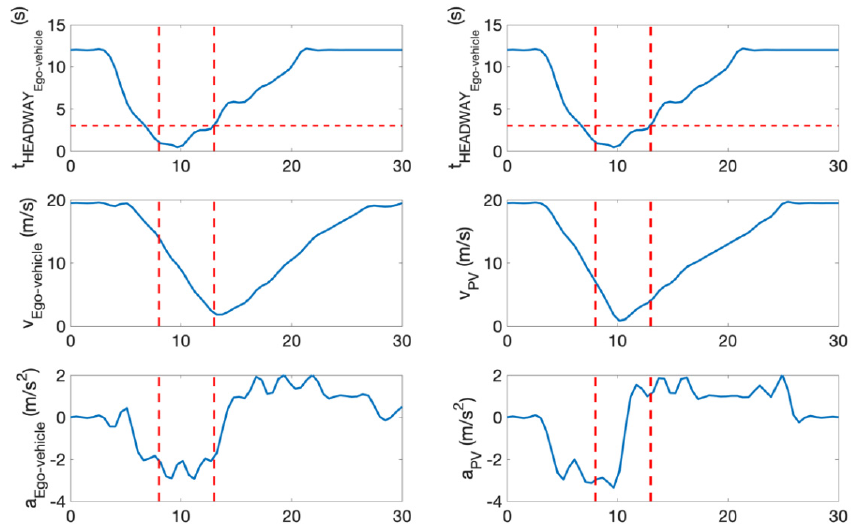
Figure 14. Time headway of ego-vehicle, velocity, and acceleration of ego-vehicle and opponent vehicle.